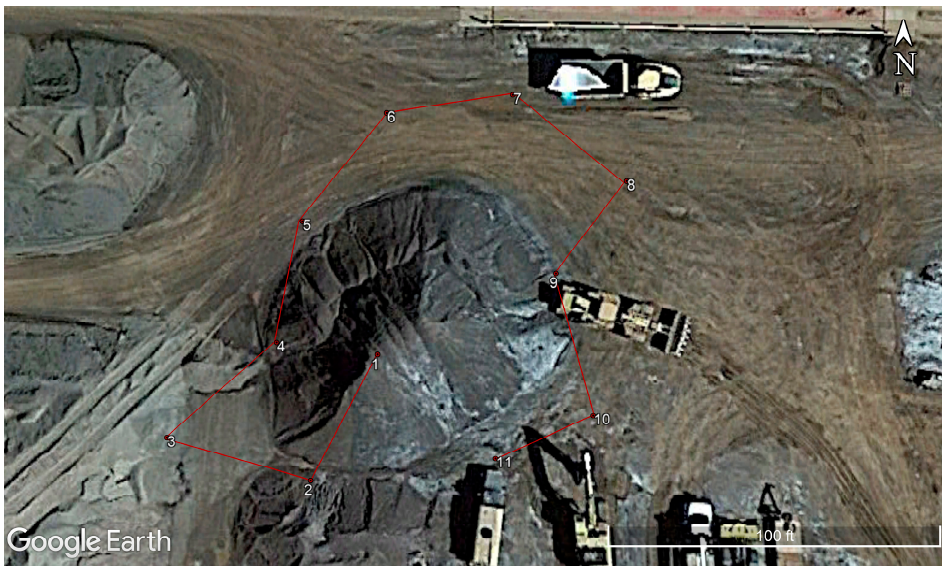
Figure 5. Positions of the drone during capture starting from point 1 till point 11 (Map data ©2023, reproduced with permission from Google, 2023).